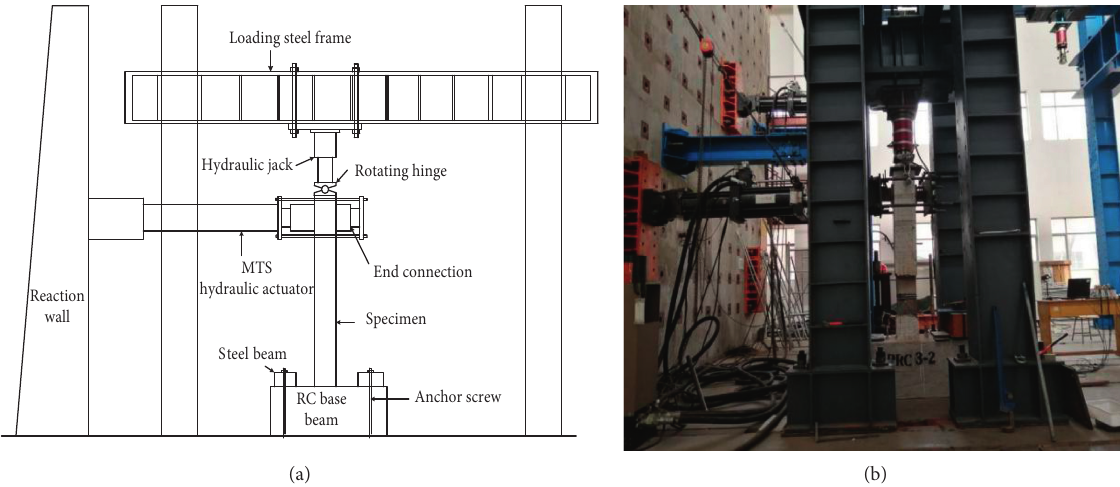
Figure 5: Test loading device: (a) schematic diagram of the test loading device; (b) loading device in field test.